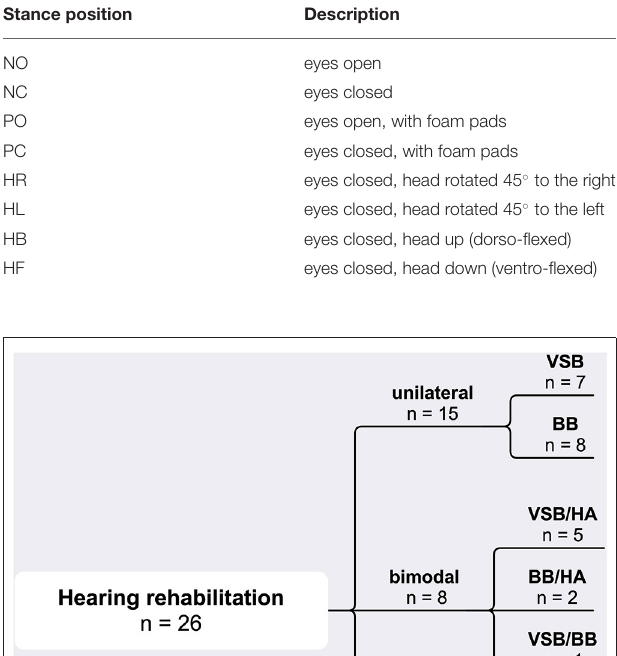
(BA: 67.1 cm, SD = 23.7; UA: 68.9 cm, SD = 23.5; p = 0.24, r = 0.23), angle of displacement α (BA: 18.9 ◦ , SD = 11.4; UA: 16,5 ◦ , SD = 9.9; p = 0.19, r = 0.26) and angle of rotation β (BA: 40.2, SD = 35.3; UA: 40.7, SD = 34.6; p = 0.869, r = 0.03) ( Figure 1